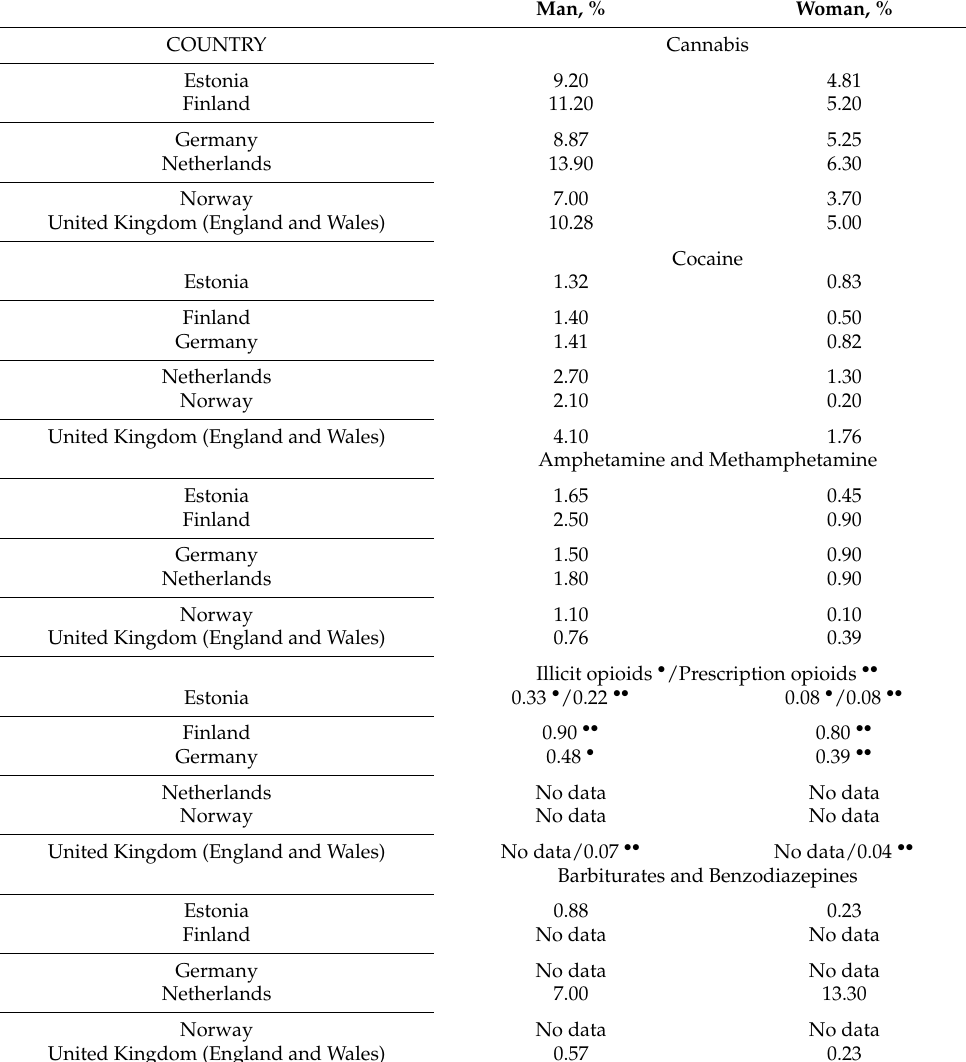
Table 3. The data on drug abuse by sex or gender during 2018, according to Statistical Annex of United Nations Office on Drugs and Crime in population aged 15–64 in some European countries